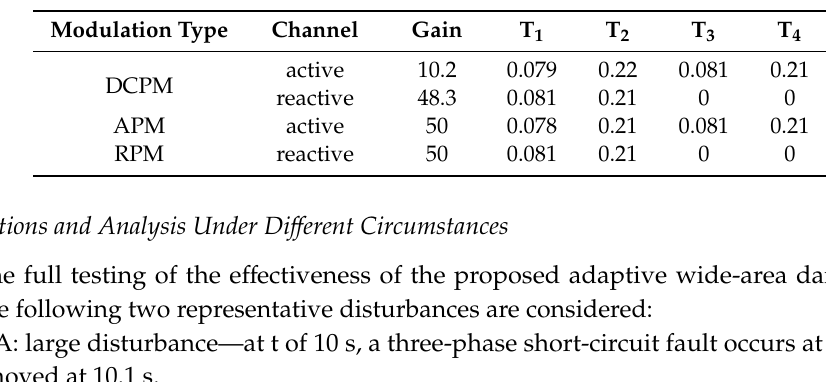
Table 1. Parameters of different modulation damping controller. DCPM: dual-channel power modulation; APM: active power modulation;